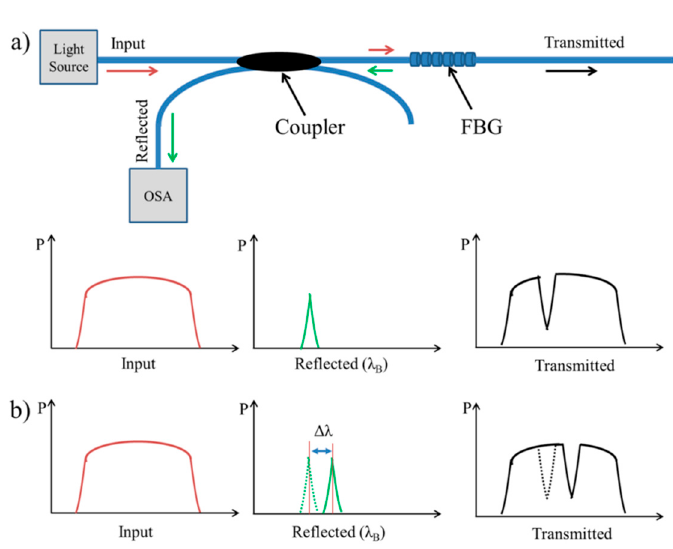
Figure 5. FBG sensor working principles; ( a ) the light spectrum (brown color) passes through the FBG fiber and a narrow wavelength band (green arrow) is back-reflected and monitored by OSA; ( b ) the back-reflected wavelength is shifted ( Δλ ) shortly after applying external perturbations [75].